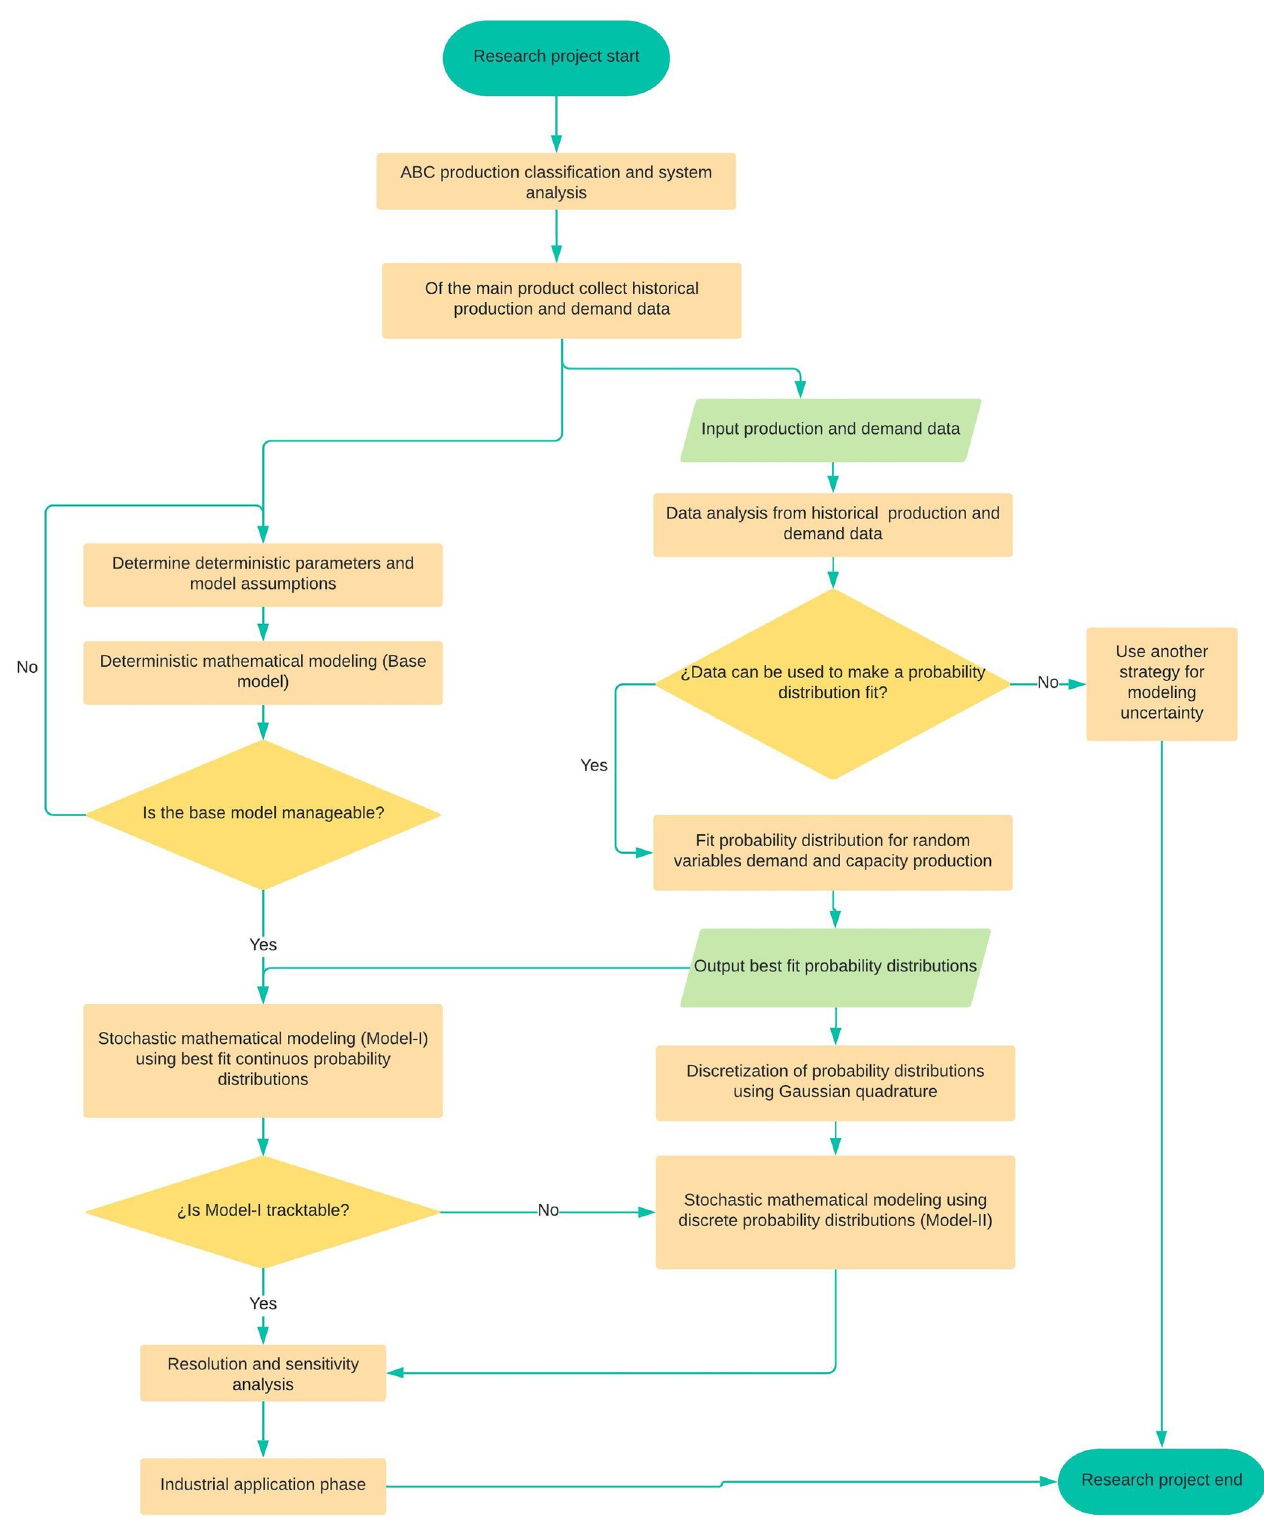
Fig 2. Flow chart of the methodology. Own elaboration.